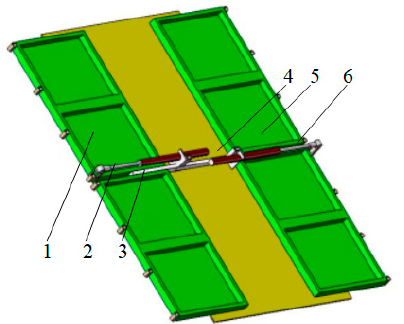
Figure 6. Structural diagram of the high-level extendable working platform. 1 and 5 represent ex- pansion pedals, 2 and 6 represent the hydraulic cylinders, 3 represents the slide rail, and 4 represents the workbench.